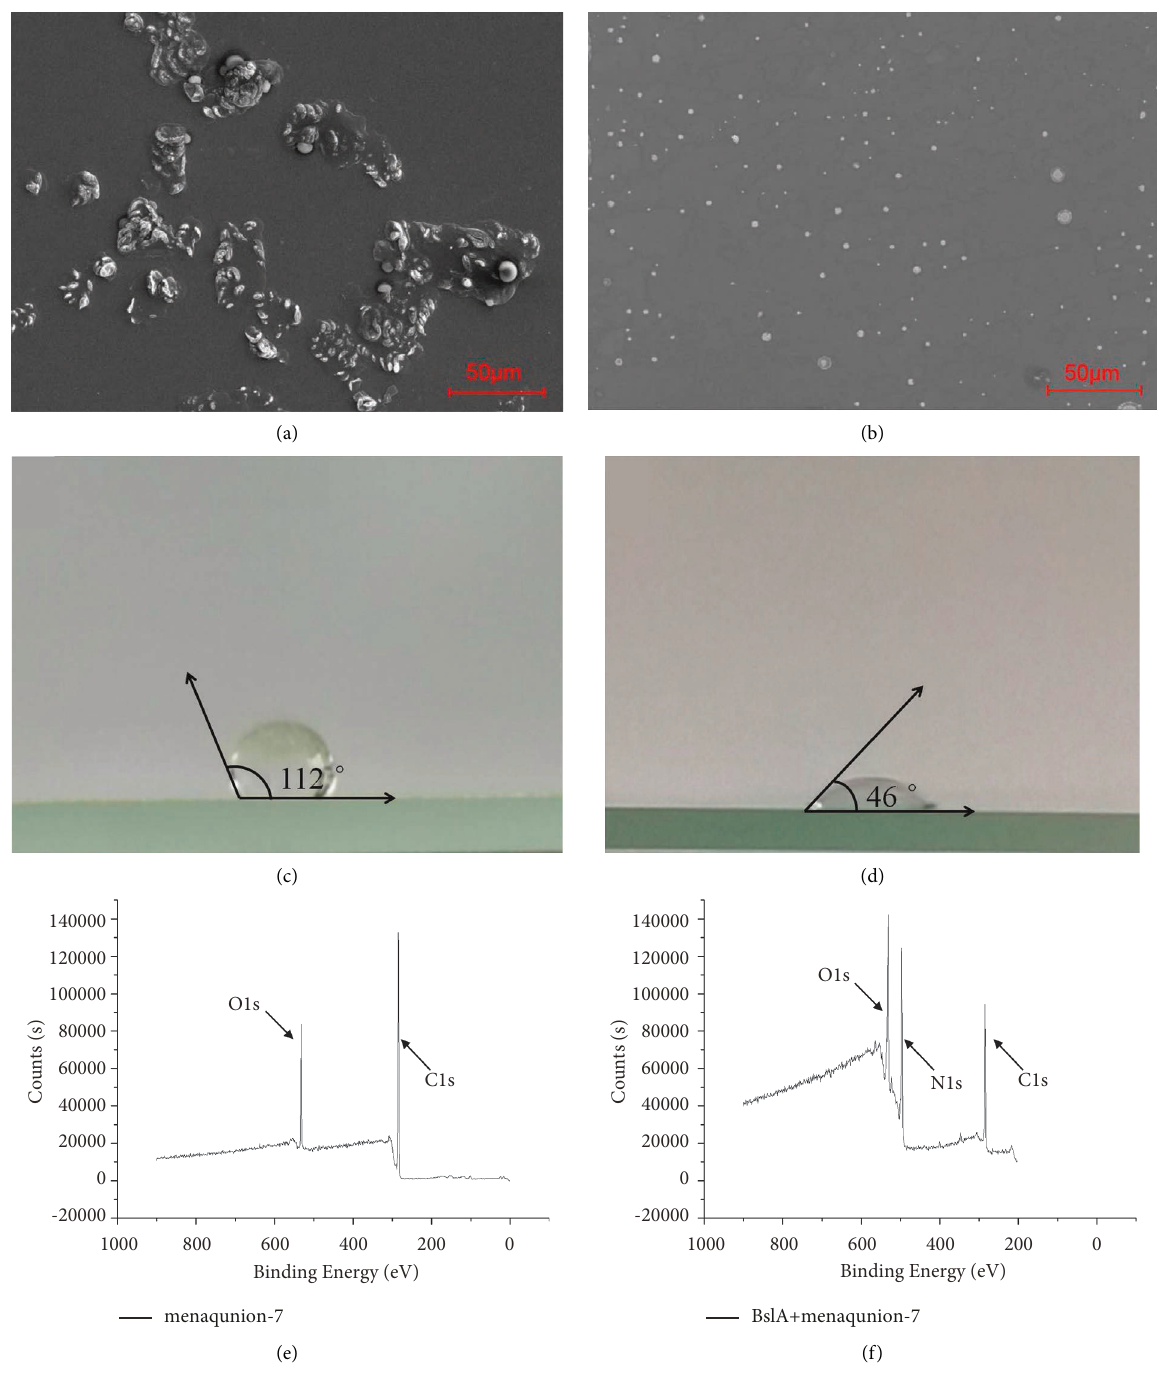
Figure 3: Physical property testing of compounds. (a) SEM of menaquinone-7; (b) SEM of BslA-modified menaquinone-7; (c) WCA of menaquinone-7; (d) WCA of BslA-modified menaquinone-7; (e) XPS of menaquinone-7; (f) XPS of BslA-modified